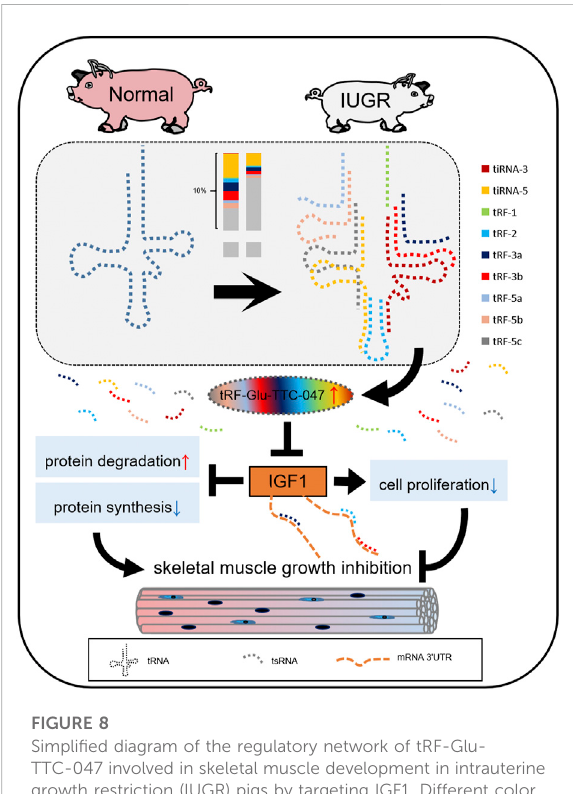
FIGURE 8 Simpli fi ed diagram of the regulatory network of tRF-Glu- TTC-047 involved in skeletal muscle development in intrauterine growth restriction (IUGR) pigs by targeting IGF1. Different color bars correspond to different types of